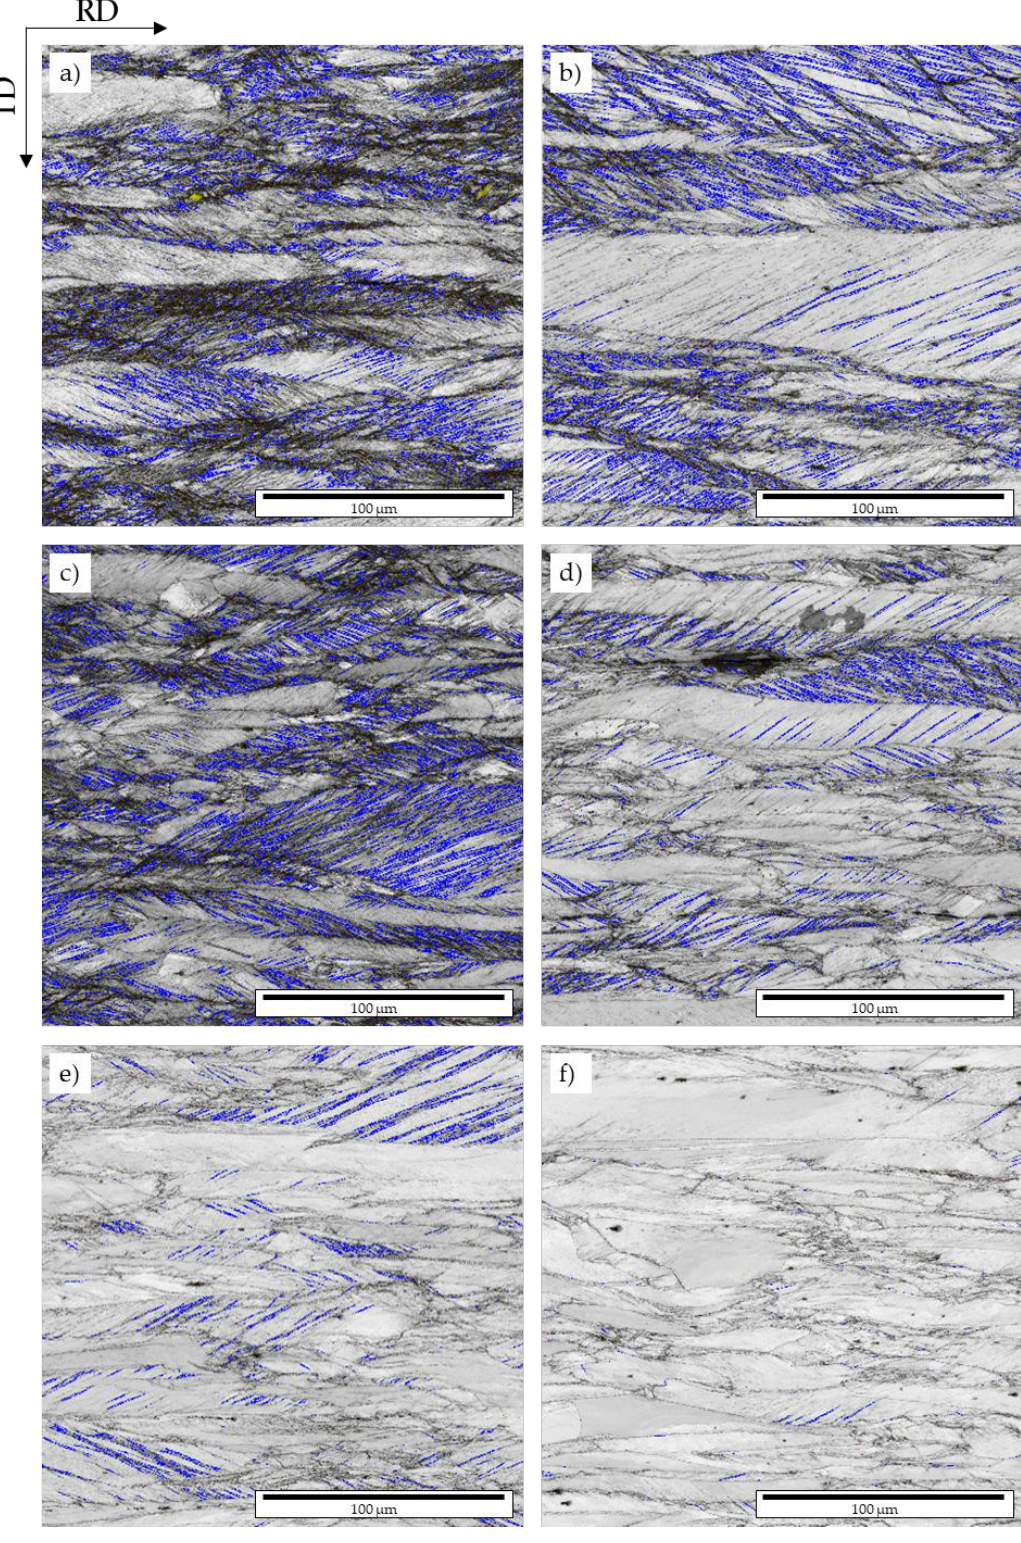
Figure 2. EBSD-IQ maps of the investigated steel deformed to 50% thickness reduction by ( a ) cold rolling and warm rolling at ( b ) 200 °C, ( c ) 300 °C, ( d ) 400 °C, ( e ) 450 °C and ( f ) 500 °C. Blue lines indicate deformation twin boundaries (60° <111>).